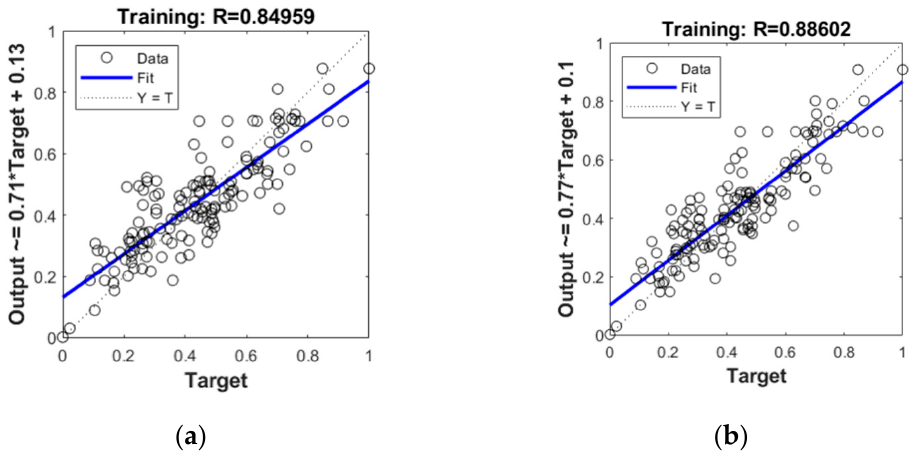
Figure 5. Regression after training for: ( a ) Initial model; ( b ) Optimized model.